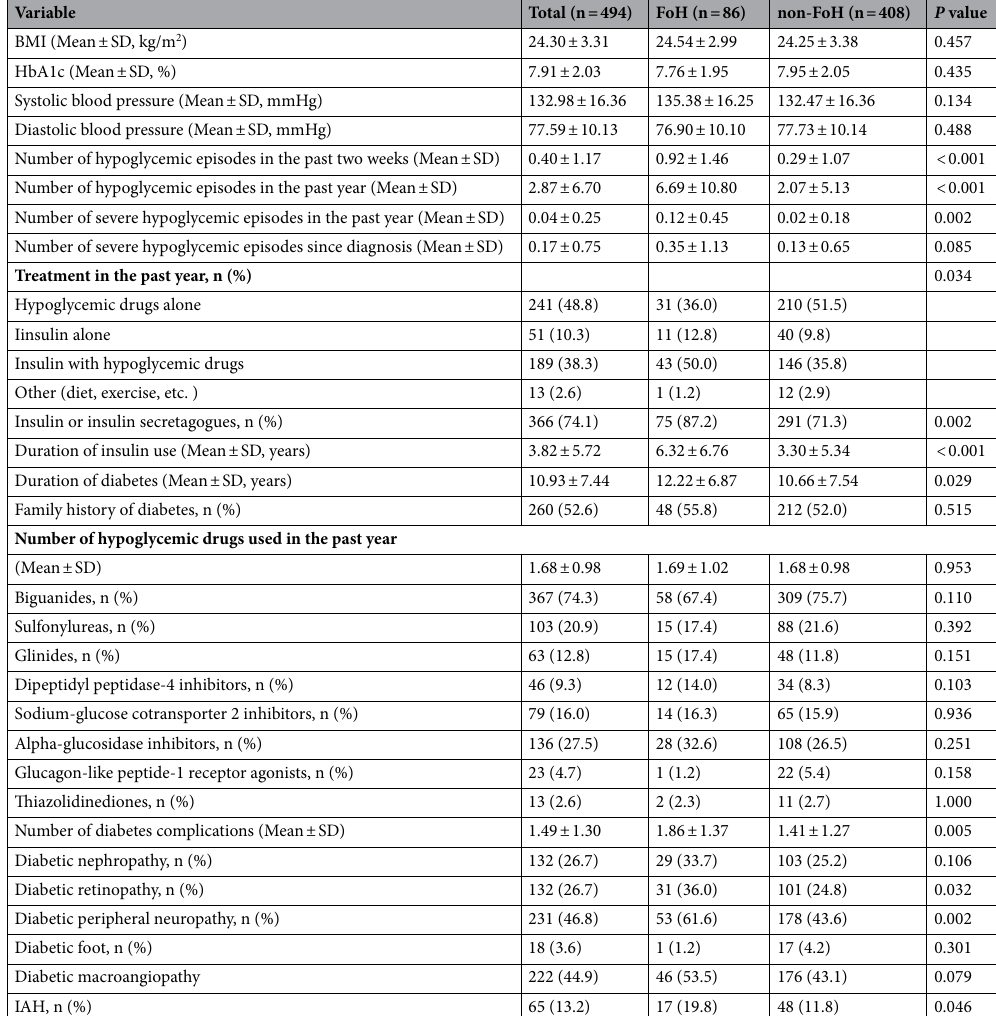
Table 2. Clinical characteristics of patients with type 2 diabetes. IAH, impaired awareness of hypoglycemia; FoH, fear of hypoglycemia; BMI, body mass index; HbA1c, glycated hemoglobin; SD, standard deviation. The independent sample t-test, the Mann–Whitney U test, Pearson’s chi-squared test, the continuity corrected chi-squared test, and Fisher’s exact test were used to compare differences between groups. Hypoglycemia was defined as a plasma glucose level ≤ 3.9 mmol/L in patients with diabetes and severe hypoglycemia was defined as any hypoglycemic episode that led to seizures, loss of consciousness, and/or urgent medical attention. The number of hypoglycemic episodes was self-reported by patients on a questionnaire based on blood glucose self-monitoring diaries and their own memories.